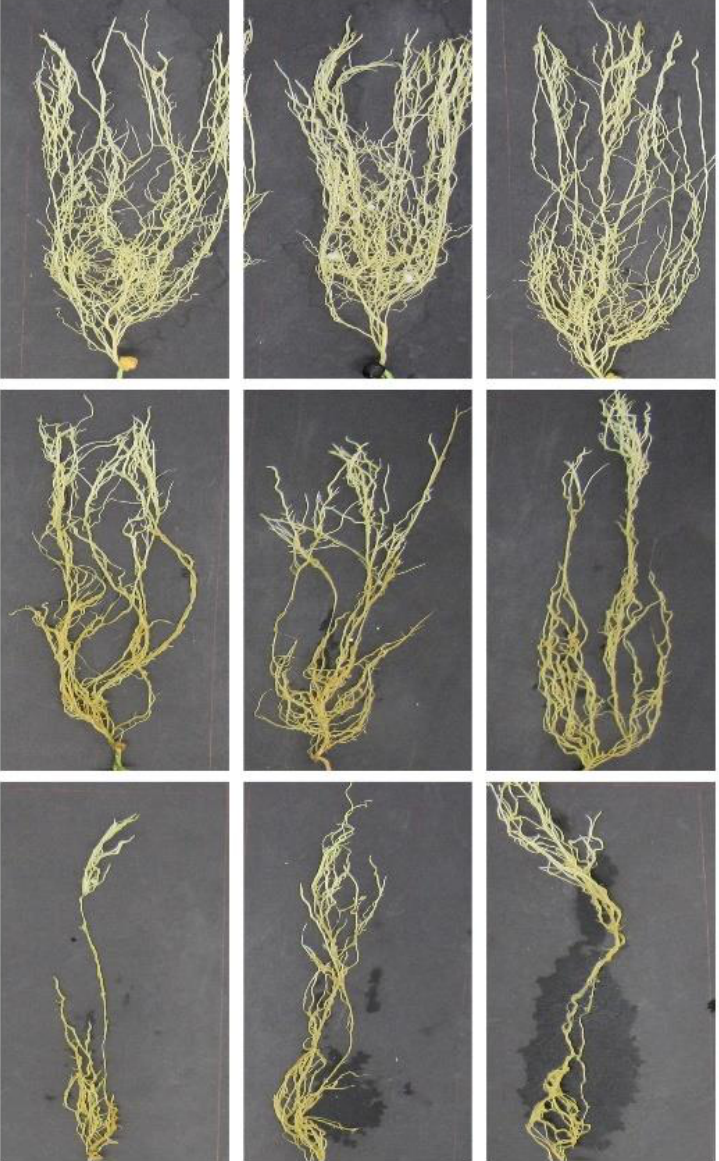
Figure 1. Sample pea root images from the three classes: healthy/resistant ( first row ), intermediate ( second row ), and susceptible ( third row ).